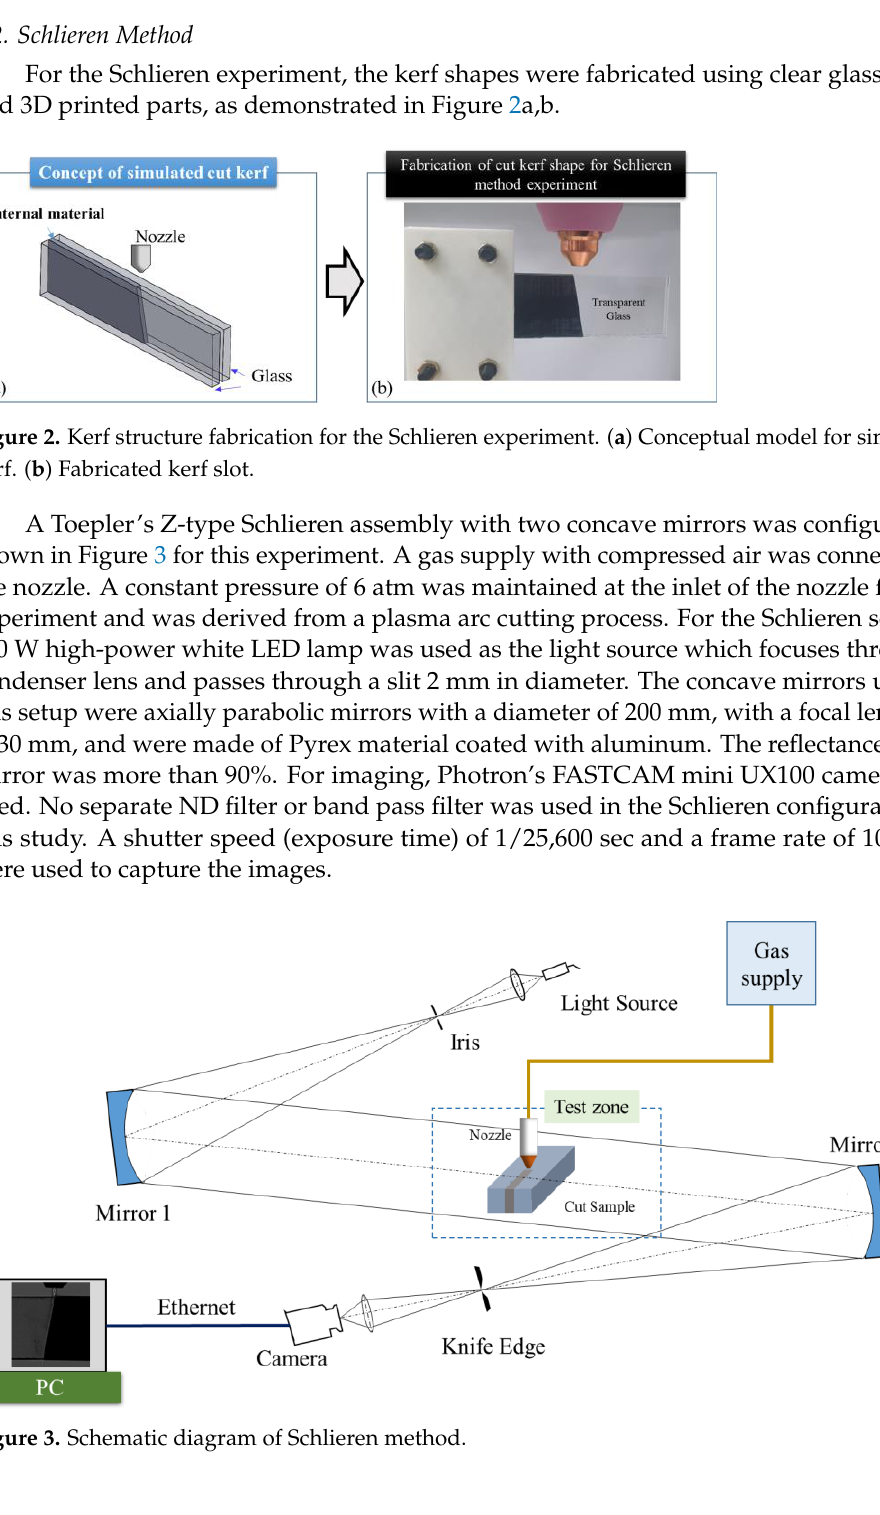
Figure 1. Detailed geometry of nozzle and kerf. ( a ) Nozzle. ( b ) Section view of kerf (perpendicular